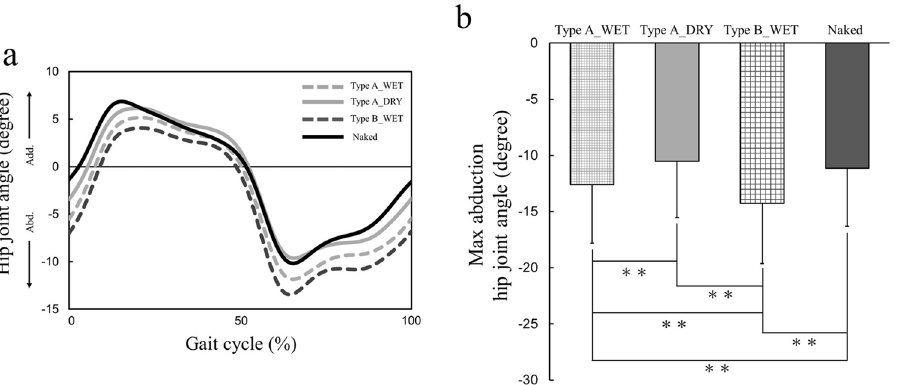
Figure 2. ( a ) Mean time series across subjects at each condition of the hip joint angle in the frontal plane during a gait cycle. Abd abduction, Add adduction. ( b ) Mean and standard deviation of the mean of the normalized maximum abduction hip joint angle for the four dress conditions. *p < 0.05; **p < 0.01.